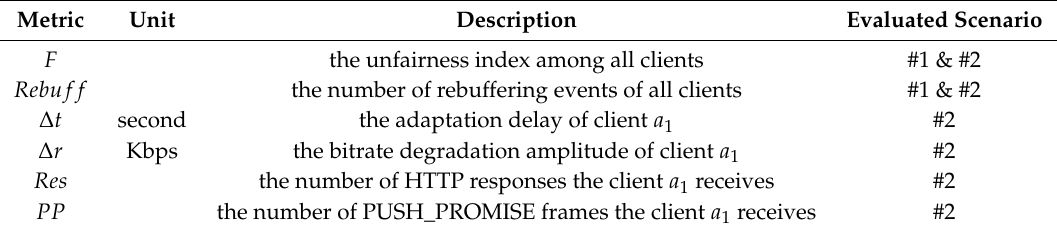
Table 5. Evaluation